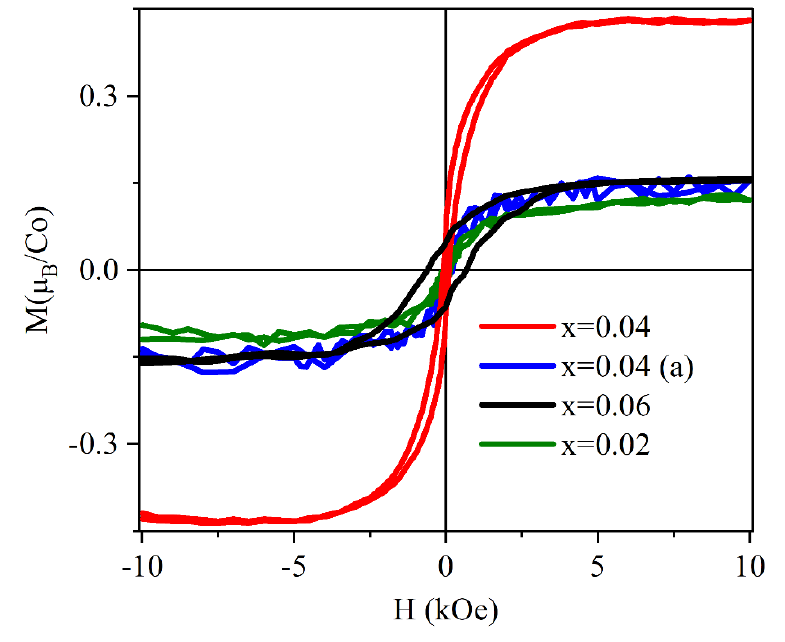
Figure 3. Hysteresis cycle for the four investigated epilayers (after subtraction of the substrate signal); 0.04 ( a ) indicates an oxygen annealing. Reproduced with permission from [73]. Copyright 2001 American Physical Society.